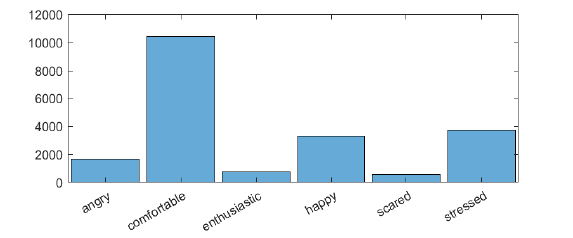
Figure 3. Distribution of classes within the data set.